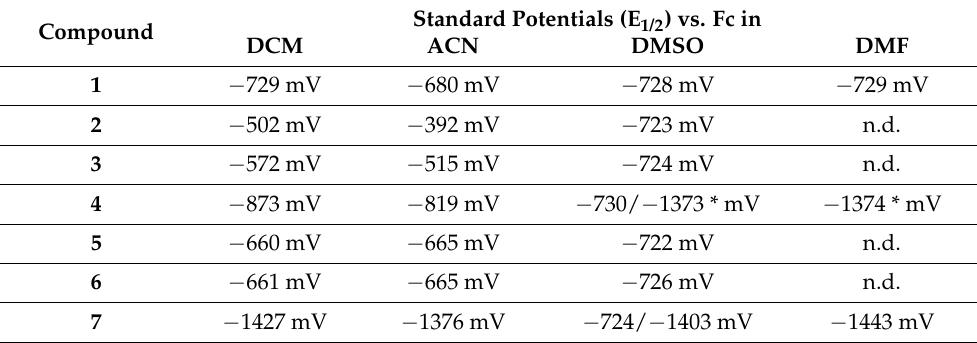
Table 3. Standard potentials (E 1/2 ) vs. ferrocene (Fc, 2 mM) of the complexes (1 mM) in DCM, ACN, DMSO, and